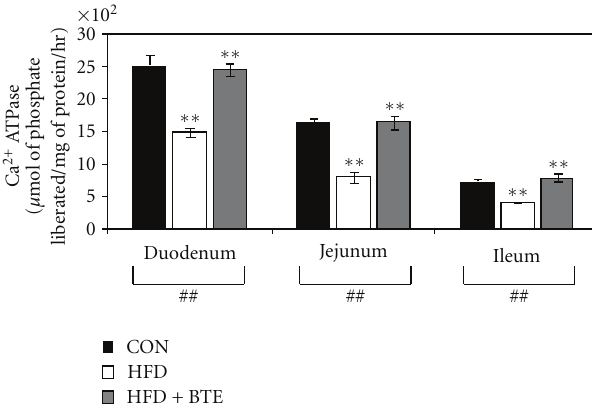
Figure 5: Ca 2+ -ATPase activity of intestinal mucosal extracts in duodenal, jejunal, and ileal segments of control (CON; Group A), HFD treated (Group B), and HFD + BTE supplemented (Group C) groups of rats. Values are expressed as mean ± S.E.M. ( n = 6). ## P < . 01 denotes significance level based on Kruskal-Wallis nonparametric ANOVA test and ∗∗ P < . 01 denotes significance level based on Mann-Whitney “U” multiple comparison test.